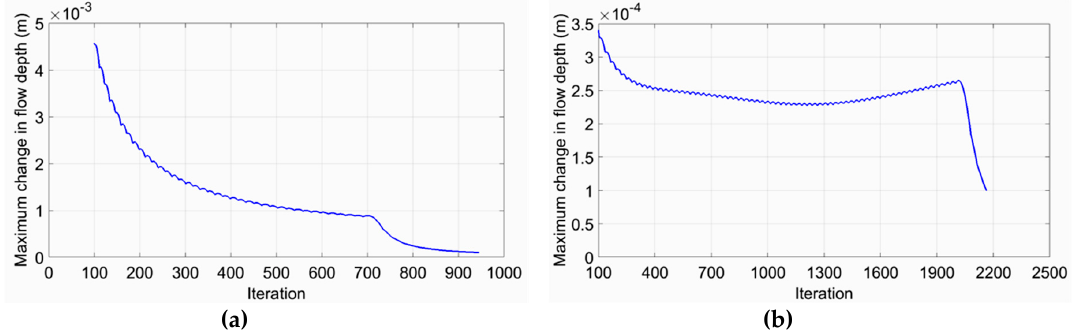
Figure 8. Variation of the mean velocity alongside the channel: ( a ) for test case 1; ( b ) for test case 6.